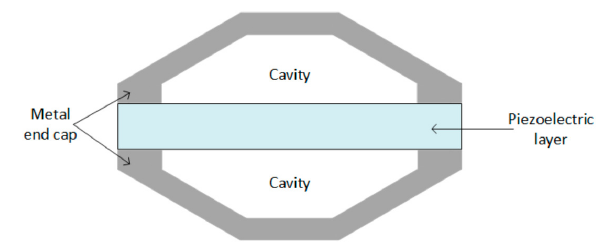
Figure 5. Cymbal Transducers.